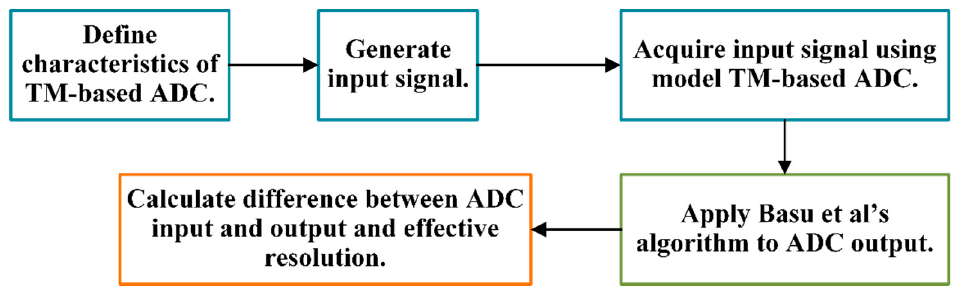
Figure 10. Modified MATLAB script employing Basu et al.’s algorithm.